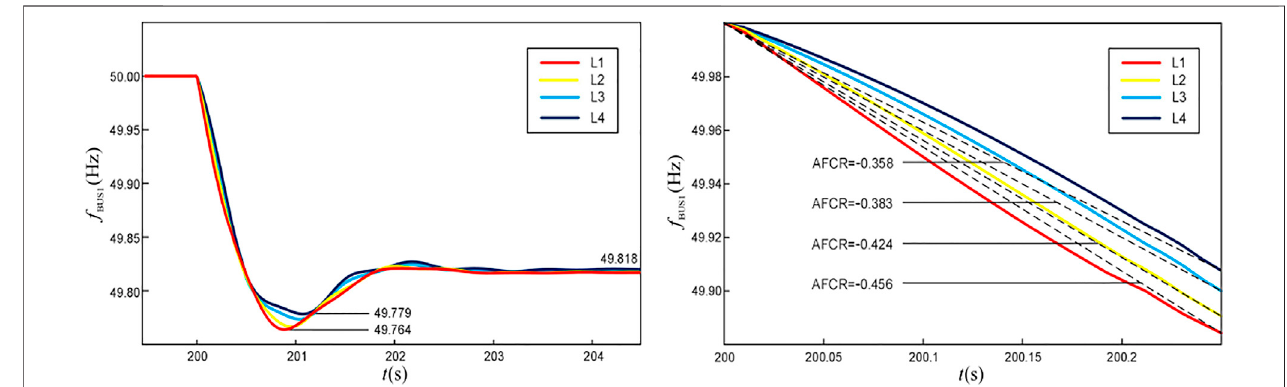
FIGURE 4 | Frequency response of the system at Bus 1.